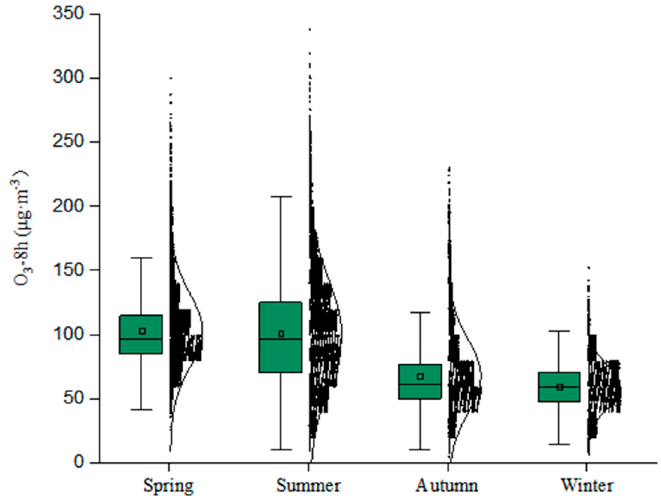
Figure 3. Seasonal variation in of O 3 -8 h from 2017 to 2020 in Northeast China. (The middle horizontal line of the boxplot represents the median O 3 concentration; the top and bottom of the box are the top quartile and the bottom quartile. The scatter plot to the right of the boxplot represents the distribution of O 3 concentration, and the curve represents the trend of O 3 concentration).